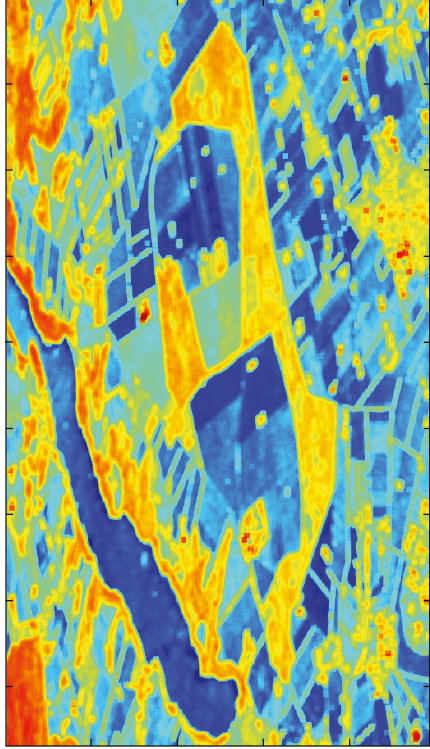
Figure 11: Brightness measure ( μ z ) image showing low values for some fields and water, high values for forest and urban areas, and particularly bright for certain buildings that presumably faced the radar. Some range e ff ect is also visible towards the left-hand edge of the